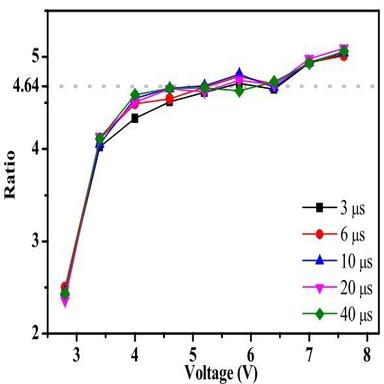
The ratio of the average photon number (n) over the average voltage.